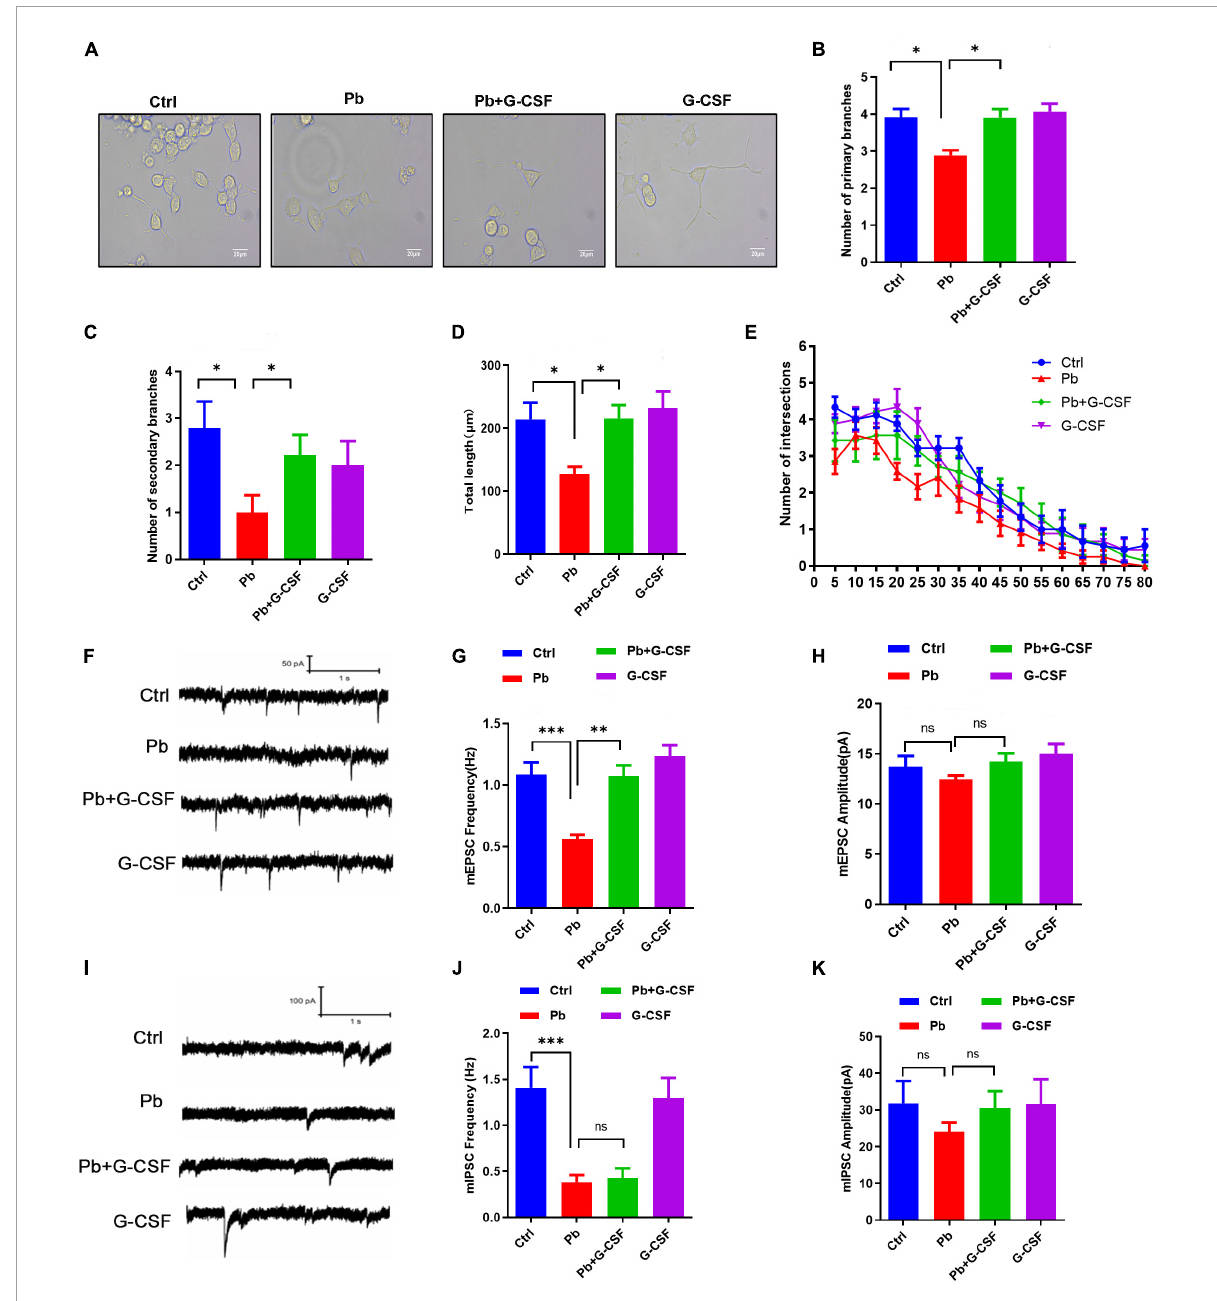
FIGURE7 G-CSF treatment attenuates Pb-induced neurotoxicity. (A–E) Representative images of neurite outgrowth in PC12 cells upon various treatments (A) scale bar = 20 µ m. The number of primary branches (B) , secondary branches (C) , total length (D) , and Sholl analysis (E) of neurite outgrowth of PC12 cells upon various treatments ( ∼ 50 cells). (F–H) Representative traces of miniature excitatory postsynaptic current (mEPSC) recording from cultured neurons treated with Pb, Pb + G-CSF, and G-CSF. The quantification of mEPSC frequency (G) and amplitude (H) from cultured neurons. (I–K) Representative traces of miniature inhibitory postsynaptic current (mIPSC) recording from cultured neurons treated with Pb, Pb + G-CSF, and G-CSF. The quantification of mIPSC frequency (J) and amplitude (K) from cultured neurons. Data are shown as mean ± SEM. ∗ p < 0.05, ∗∗ p < 0.01, ∗∗∗ p <